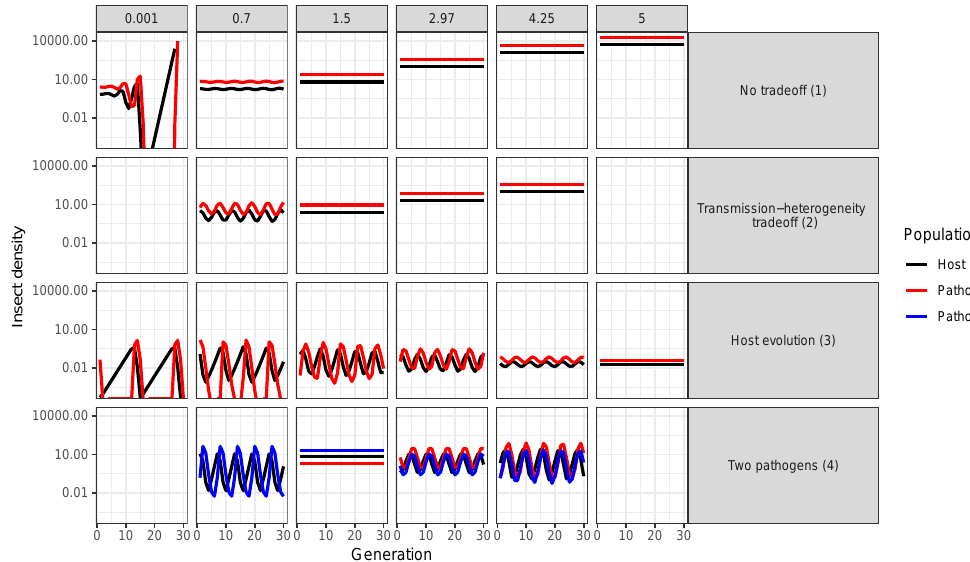
Figure 7. Host and pathogen population densities for four models (rows) incorporating heterogeneity of transmission C 2 (see Table 1) under realistic parameter values. See Figure 4b for details on models and parameter values. Heterogeneity C 2 is considered for five different cases (columns left to right): Very low heterogeneity ( C 2 = 0.001), low heterogeneity ( C 2 = 0.7), intermediate heterogeneity ( C 2 = 1.5; the minimum value value where two-pathogen coexistence occurs in Model 4), high heterogeneity ( C 2 = 2.97, the realistic estimate for the host evolution model (Model 3) see [15], and very high heterogeneity ( C 2 = 5; the maximum heterogeneity considered). Note that the range of possible heterogeneity values is restricted by the transmission-heterogeneity tradeoff function for Models 2 and 4, and thus the lowest and highest cases are missing for these models. Notice also that for near-zero heterogeneity and no tradeoff (upper left corner), neither the host nor the pathogen go extinct, rather, they reach values very close to zero and so eventually the the host population